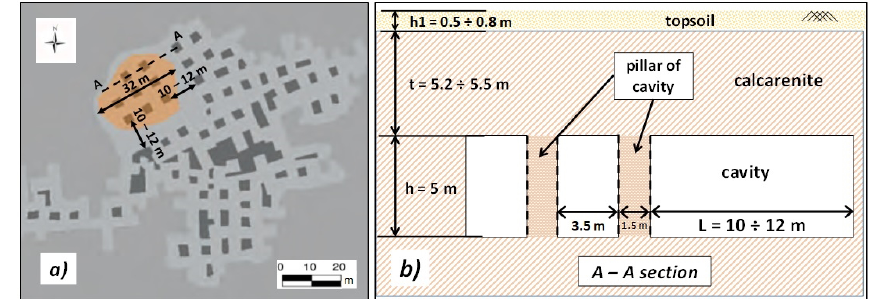
Figure 6. (a) Schematic map of the Barletta underground calcarenite quarry (adapted from Luisi et al., 2015; the area involved in the collapse is shown in orange, pillars are in dark gray, and tunnels and excavated zones are in light gray); (b) original stratigraphy of the cavity (before collapse).